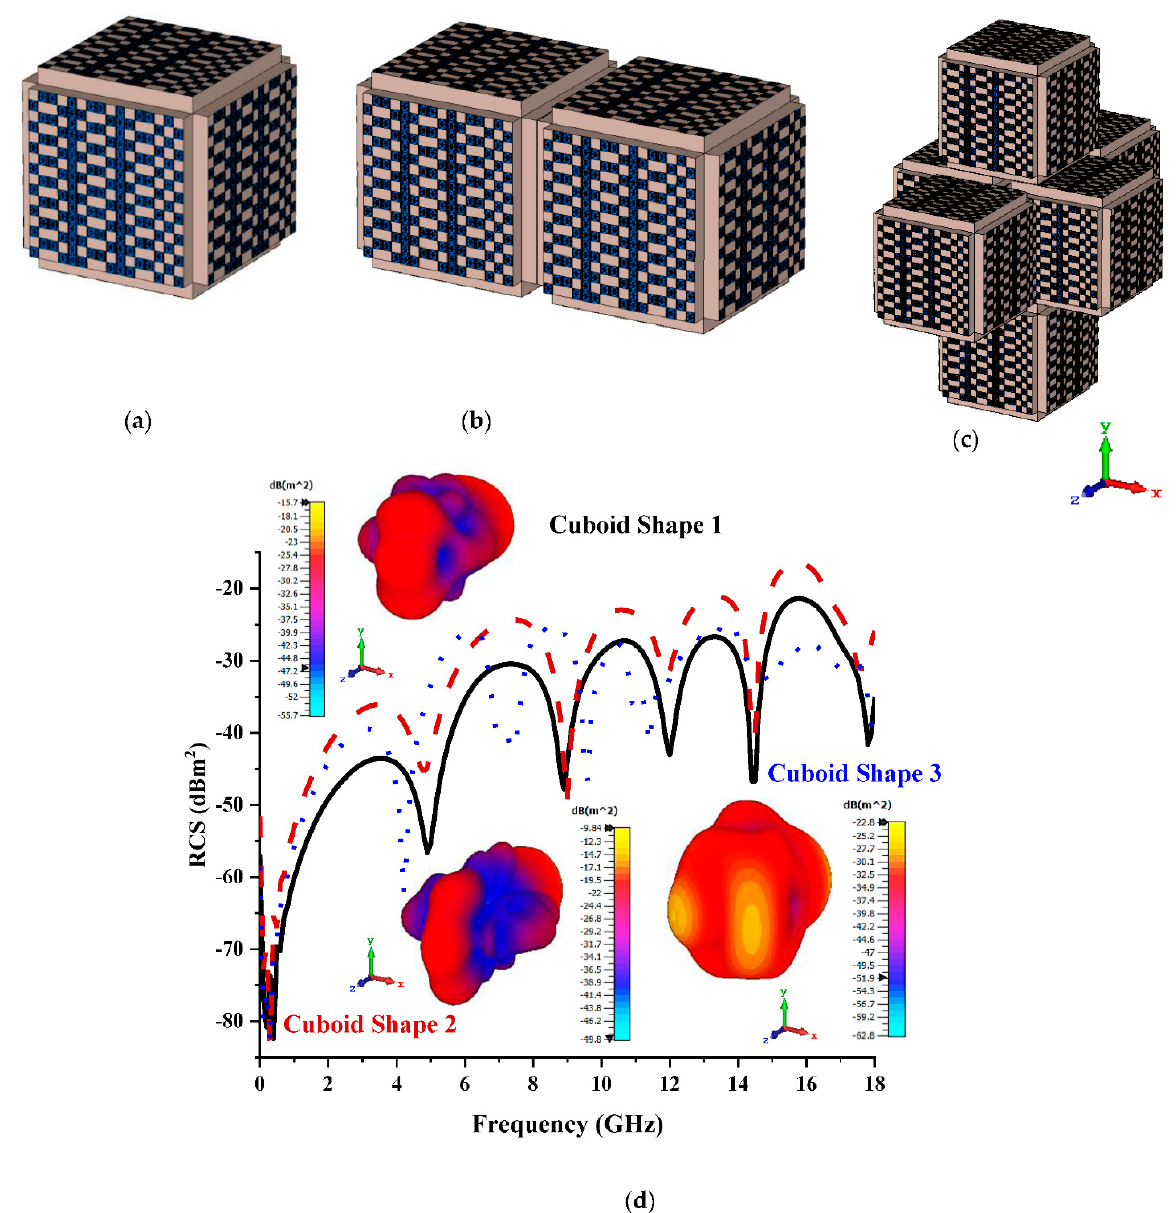
Figure 9. Sixteen lattices: ( a ) Cuboid Shape 1; ( b ) Cuboid Shape 2; ( c ) Coding Shape 3; ( d ) monostatic RCS and bistatic scattering pattern at 15